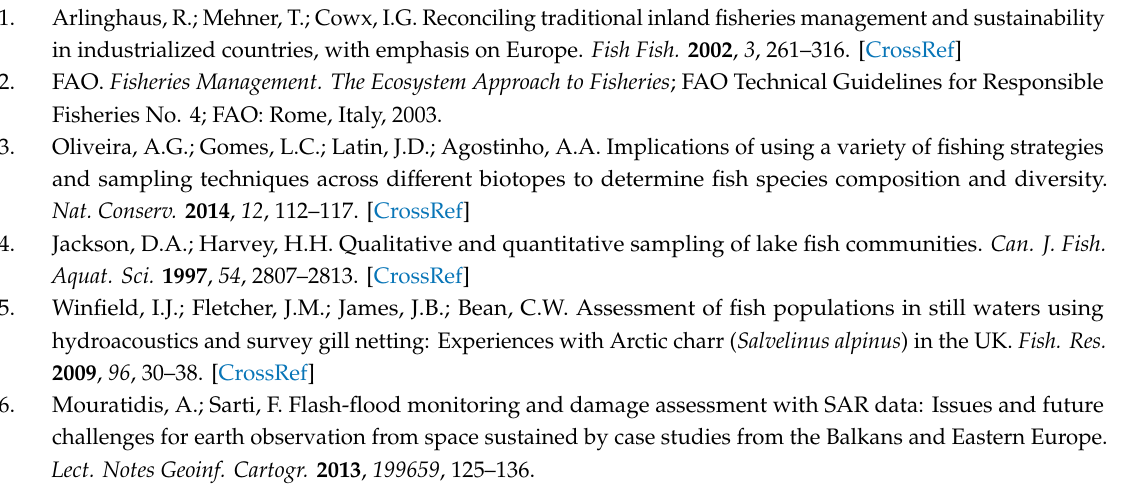
Figure S1: Empirical distribution functions for TS, categorized in 2-dB bins separately for day and night, as well as for the sets of all sampled cells, and of only cells with N V < 0.1. Figure S2: Sawada N V index vertical distribution with 1-sigma confidence intervals (left) and day-night di ff erence, i.e., day values minus night values